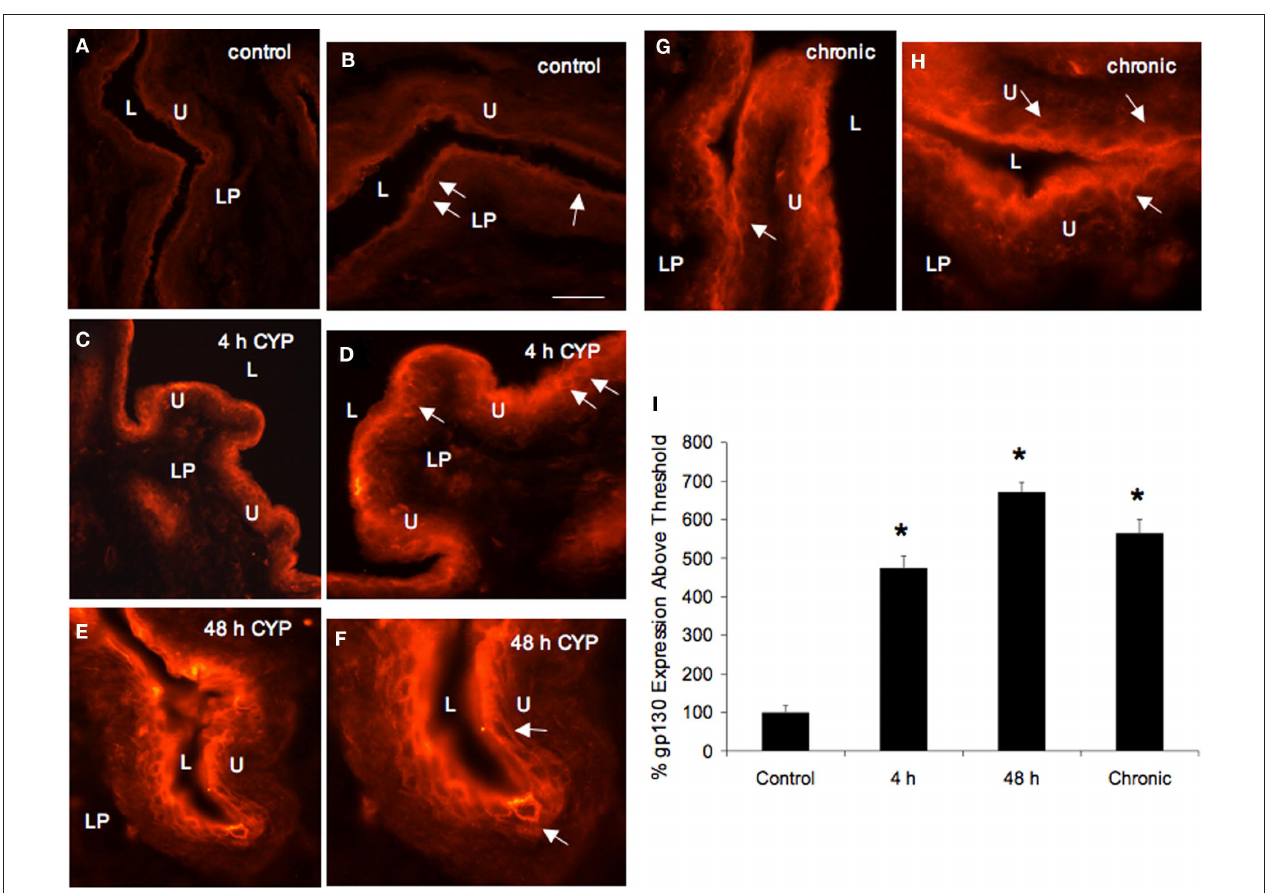
absent from the lamina propria (LP) of the urinary bladder from control or CYP-treated rats. (I) Summary histogram of percent gp130 expression above threshold in U with CYP-induced cystitis. Data are a summary of n = 6 for each group. * p ≤ 0.01 versus control. L, lumen. Calibration bar represents 80 μm in (A,C,e,g) and 45 μm in (B,D,F,H)